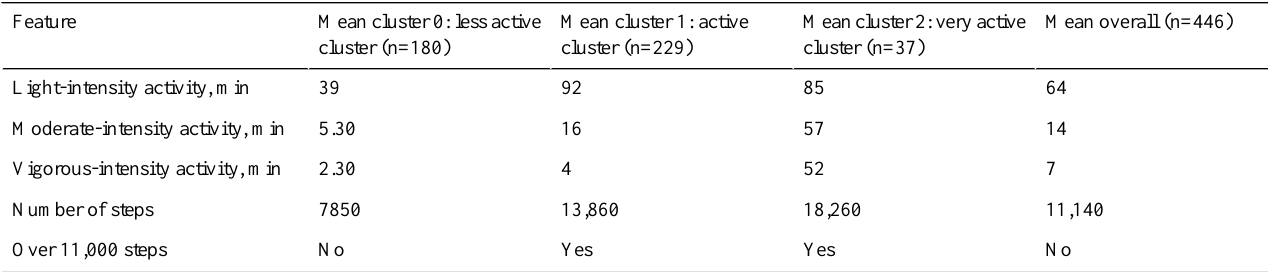
Table 2. Centroids of daily behavior clusters (k=3) during the 4-week iEngage